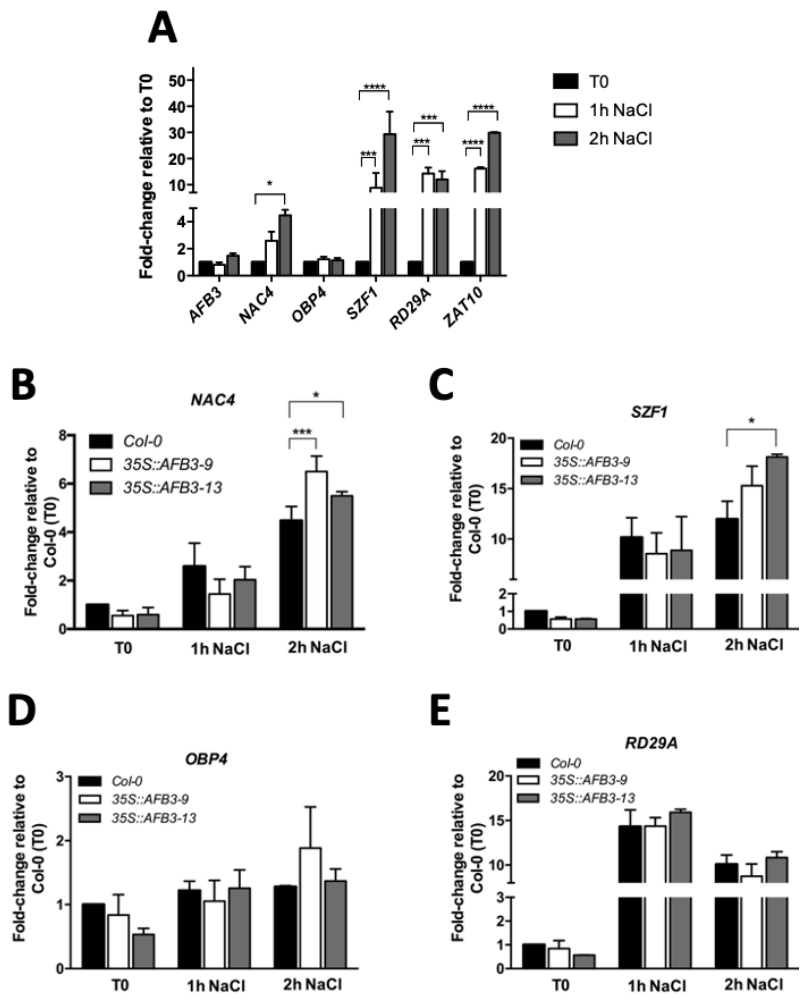
Figure 4. Putative AFB3-downstream signaling components NAC4 and SZF1 , are induced under salt stress conditions and differentially regulated in Arabidopsis thaliana AFB3 over-expressor lines. 7-day-old Col-0 WT and p35S::AFB3 lines seedlings were transferred onto 0.5× MS medium supplemented with 150 mM of NaCl. At the time of transfer (T0), 1 h and 2 h after NaCl treatment, whole roots were collected. Transcript levels were analyzed by qRT-PCR using Clathrin adaptor complex subunit (AT5G46630) as house-keeping gene. ( A ) Col-0 WT, Fold-change was set for T0. ( B – E ) Transcript levels from NAC4 ( B ), SZF1 ( C ), OBP4 ( D ), and RD29A ( E ) in Col-0 WT and p35S::AFB3 lines. Fold-change was set for T0 (Col-0 WT). Two-way ANOVA and Bonferroni a posteriori tests were performed. *: p < 0.05; ***: p = 0.001; ****: p < 0.001. Error bars represent the standard error of the mean. Each experiment was performed three times with at least 25 seedlings in each